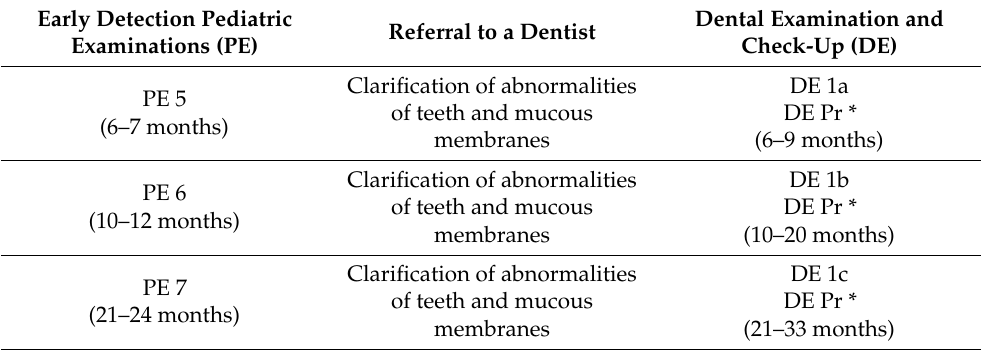
Table 1. Current guidelines in the age group of 6–33 months. Referrals to the dentist by the pediatri- cian and early dental examination and